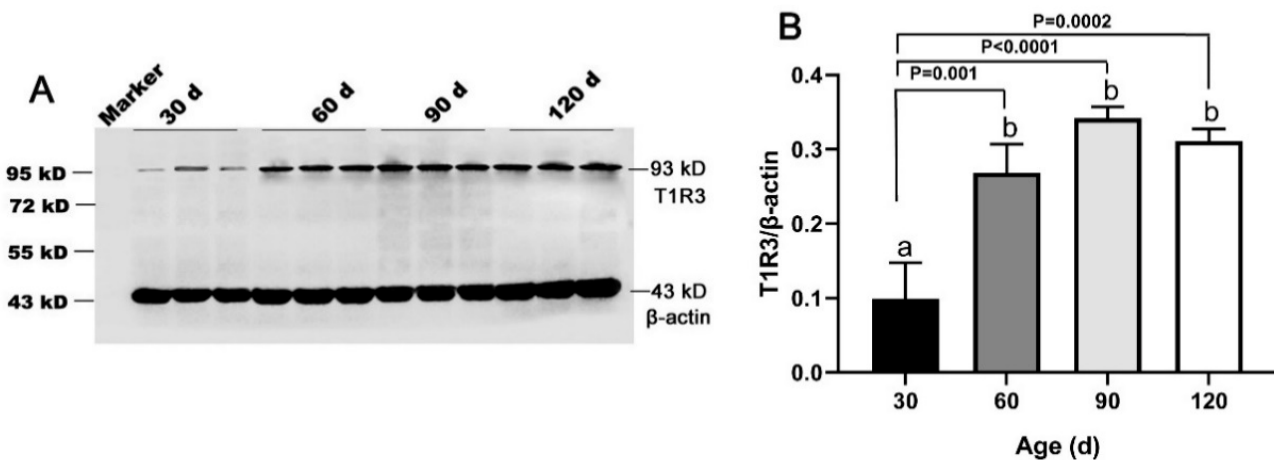
Figure 4. Expression of T1R3 in testes of Congjiang Xiang pigs at four ages. Tissues were collected from pigs at 30, 60, 90, and 120 days old. ( A ), the protein expression of T1R3 in testes from 30–120 day with western blot. ( B ), the relative expression of T1R3 from 30 to 120 day analyzed by the Image J. The expression pattern of T1R3 was measured by WB, β‐ actin was used as an internal control. The relative expression level was calculated by dividing the T1R3 signal intensity by corresponding β‐ actin intensity. Results are indicated by means ± SD (n = 3). Bars with different letters are significantly different ( p < 0.05).